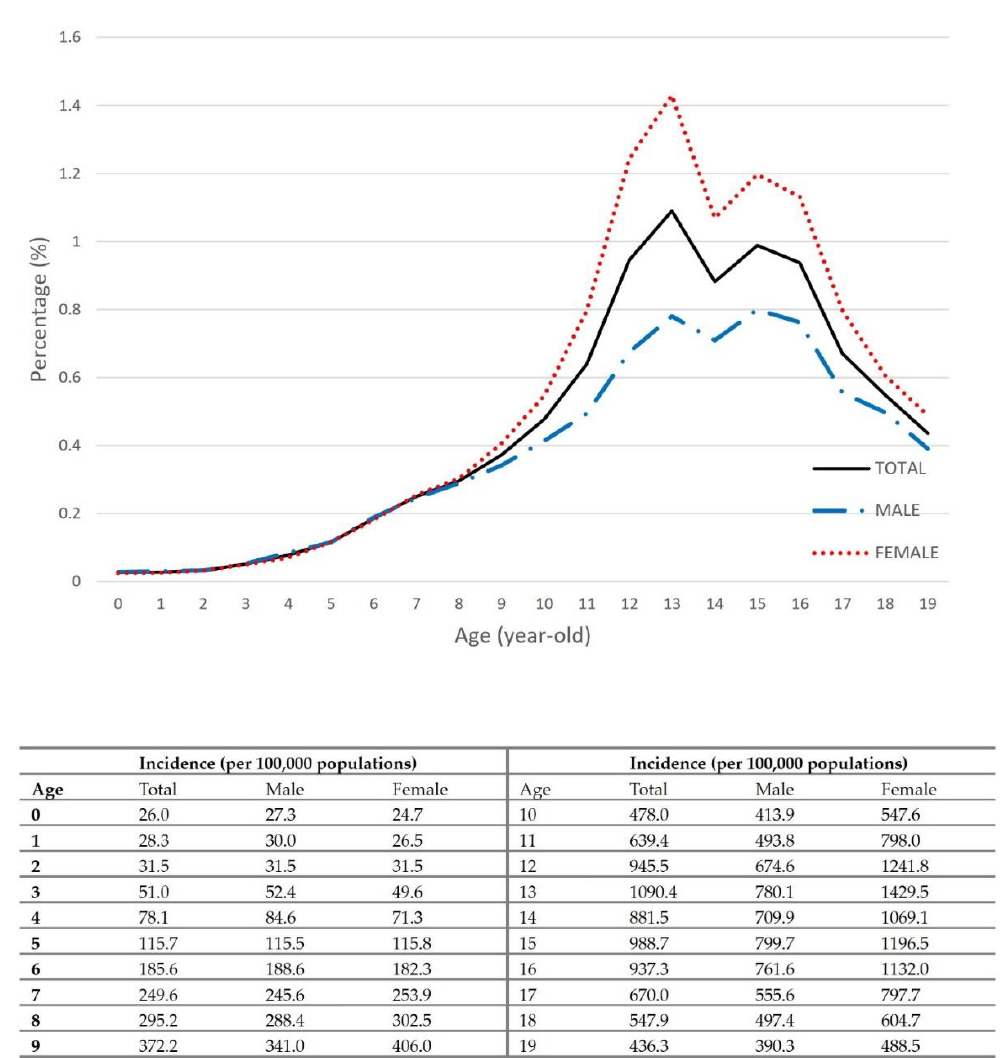
Figure 2. Age-specific incidence of idiopathic scoliosis between 2011–2015. The incidence of IIS was 29 per 100,000 population—30 in males; 28 in females, with no statistical differences between the two groups ( p = 0.1182). The overall incidence of JIS was 192 per 100,000 population—188 in males; 197 in females, which was 1.05 times higher than males ( p < 0.0001). The overall incidence of AIS was 760 per 100,000 population, with the incidence of females (928/100,000 population) being 1.52 times higher than that of males (609/100,000 population) ( p < 0.0001). The overall incidence of early AIS (10–14 years) was 821 per 100,000 population, with the incidence of females (1036/100,000 population) being 1.65 times higher than that of males (624/100,000 population) ( p < 0.0001). The over- all incidence of late AIS was 709 per 100,000 population, with the incidence of females (837/100,000 population) being 1.40 times higher than that of males (595/100,000 popula- tion) ( p < 0.0001) (Table